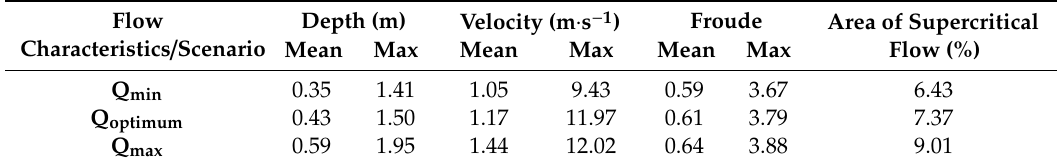
Table 2. Selected flow characteristics for flow scenarios applied in this study.